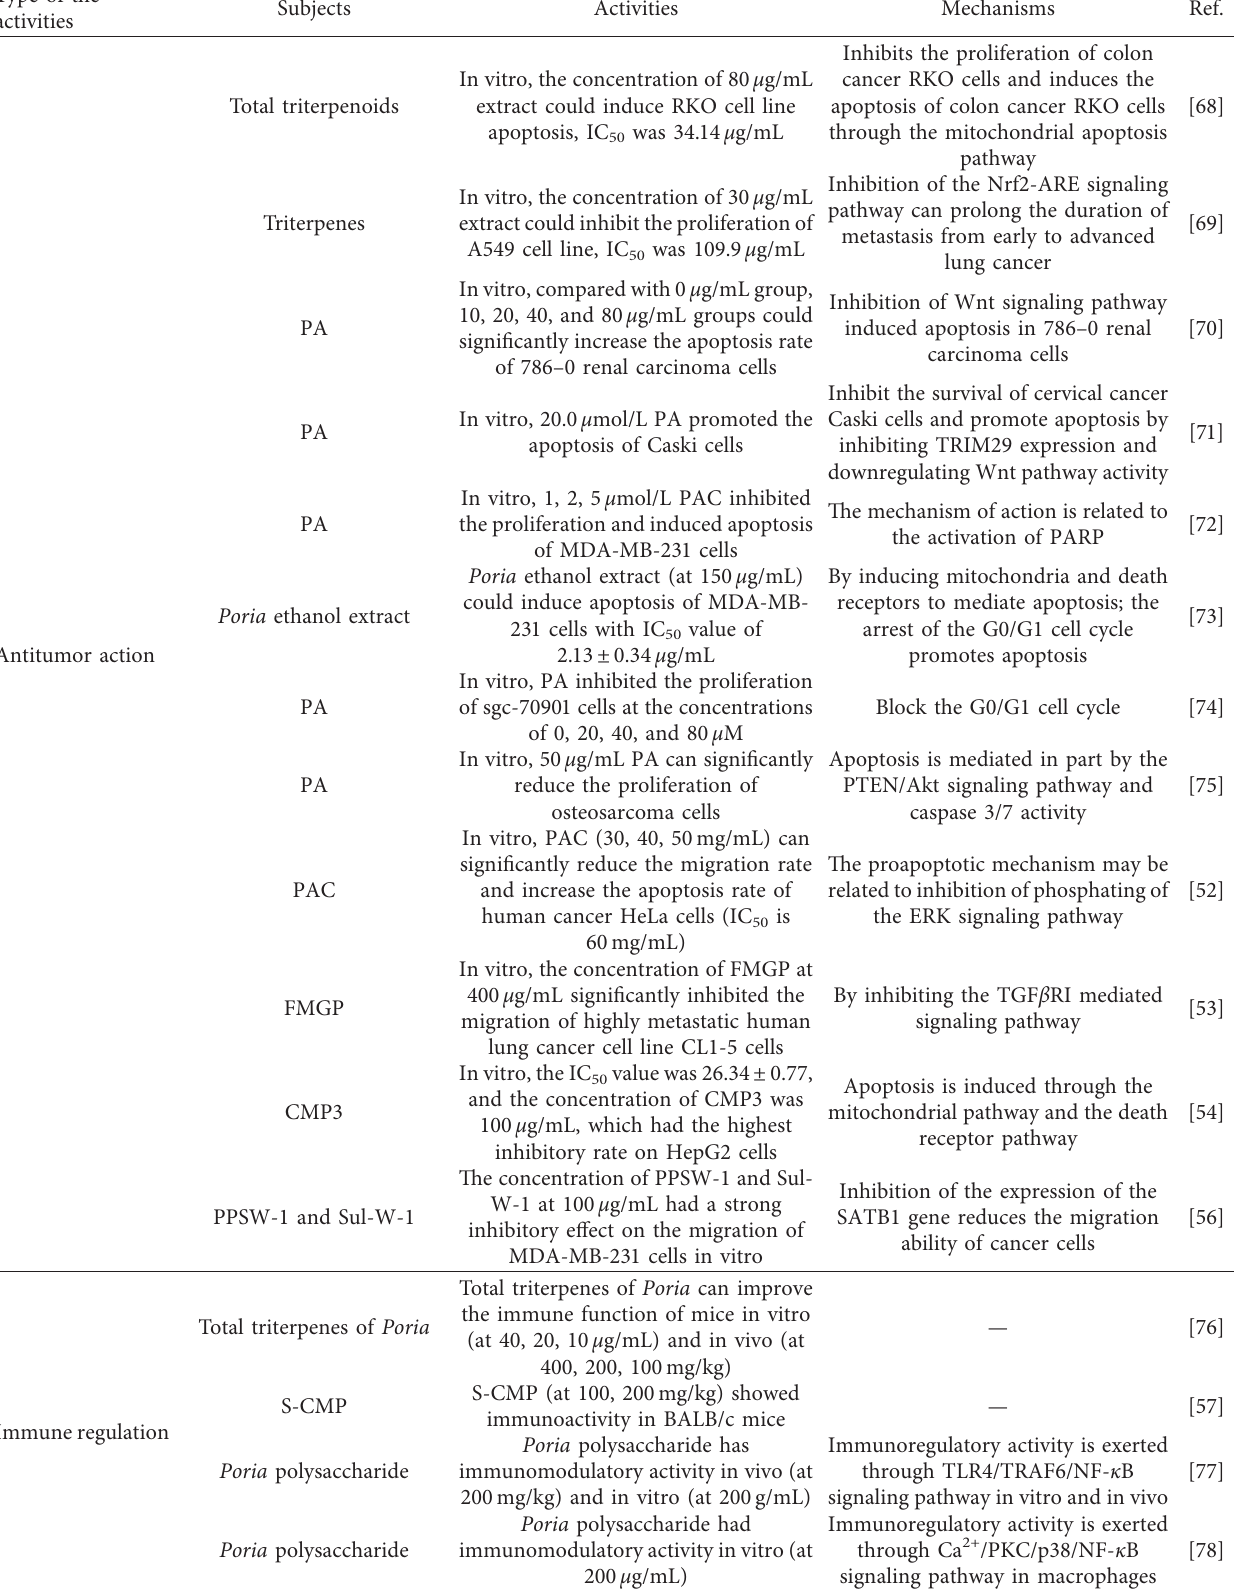
Table 3: Summary table of Poria cocos